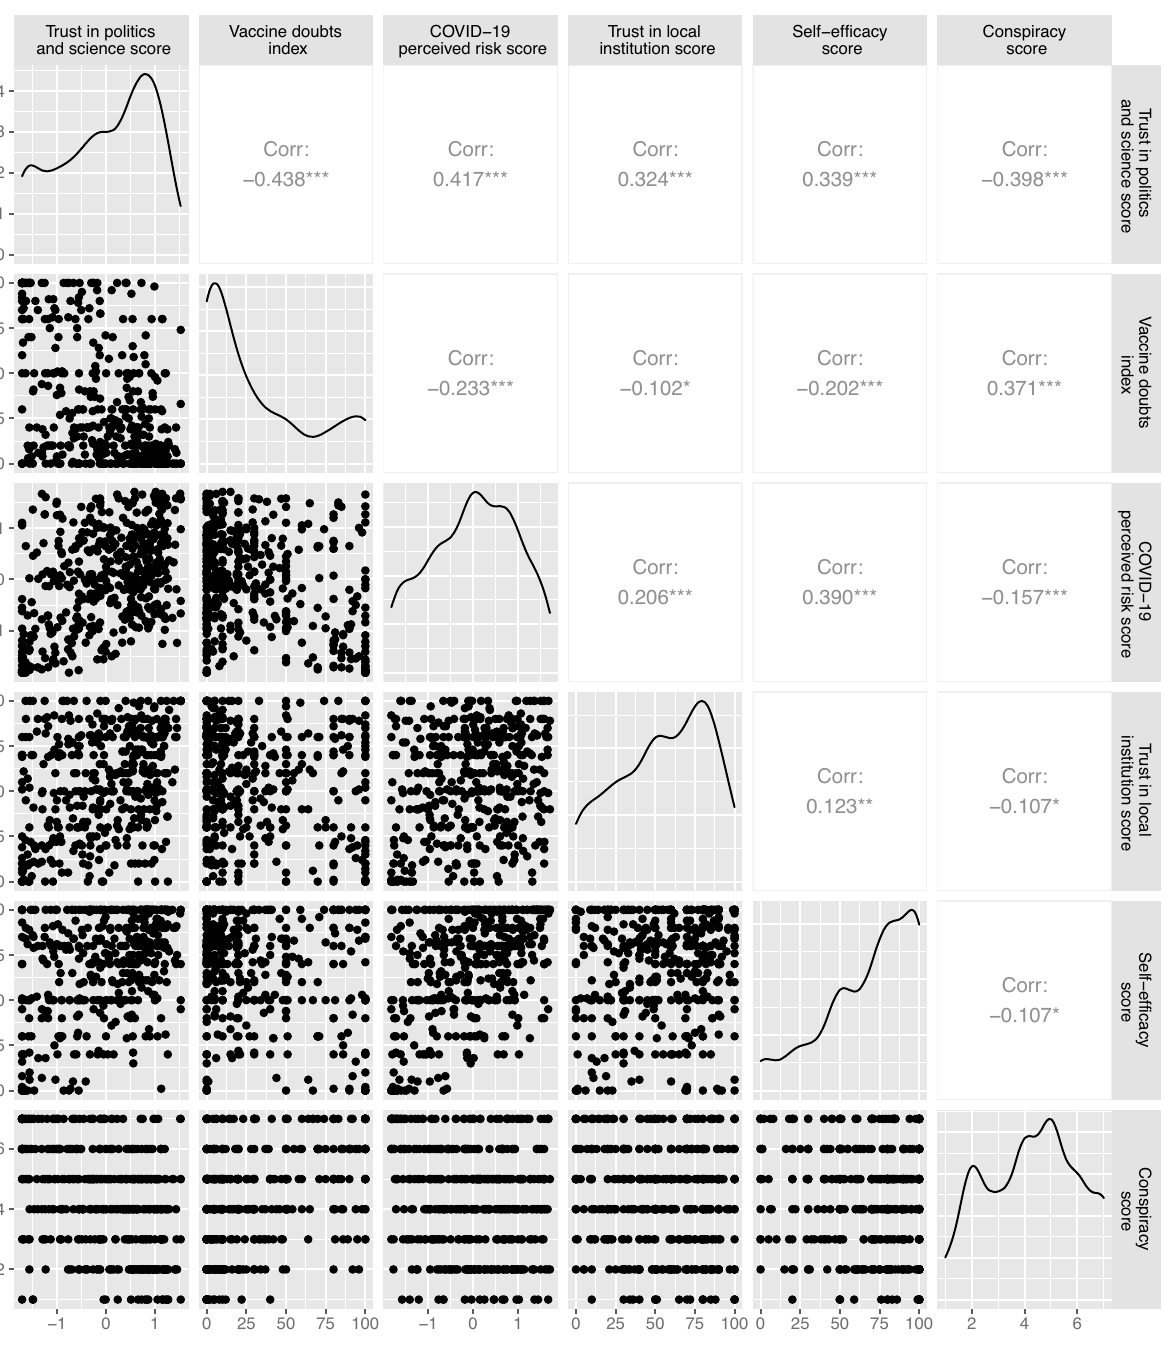
Figure 1. Marginal distribution and pairwise Spearman’s correlation between Trust in politics and science, Vaccine doubts index, COVID-19 perceived risk, Trust in local Institutions, Self-efficacy score and Conspiracy. Significance test is reported. Spearman’s rank correlation rho test: * p < 0.05, ** p < 0.01, *** p < basis of the maximized likelihood (ML) and then a Markov Chain Monte Carlo (MCMC) sampling starting from the ML estimates and with non-informative priors 37 . Coefficient estimates and the relative 95% Credible Interval (95% CrI) were obtained by the mean and the 2.5–97.5% percentiles of the a-posteriori distribution. We denote with Y = (Y 1, Y 2 ) the bivariate continuous variable associated with the likelihood to download CTA Immuni and to get the COVID-19 vaccine, respectively. Let X = [1, X 1 , X 2 ,…, X p ] T be the vector of covariates, which is (p + 1)-dimensional. Then the BBG regression model is expressed as follows: